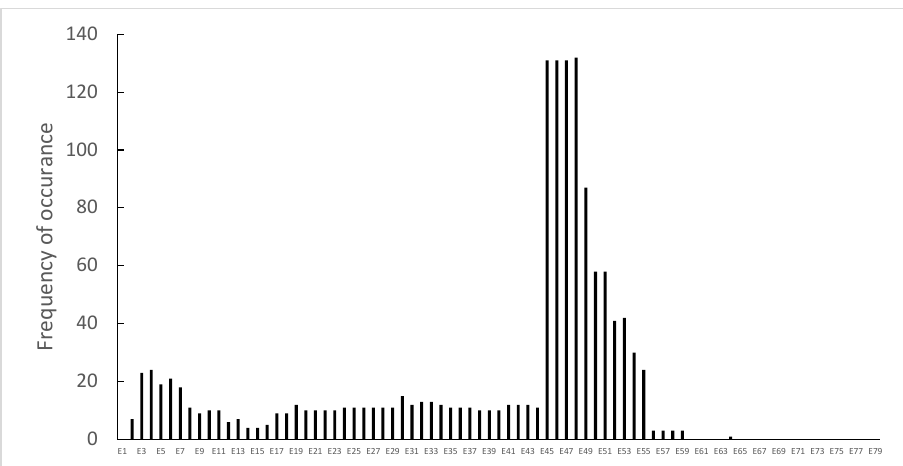
Figure 8. Frequency of single exon deletions in the dystrophin gene observed in patients with BMD. Eighteen BMD patients (6.7%) had large duplications, the largest of which involved 15 exons (E31–E44). Four patients (22.2%) had single exon duplications, which involved exons E2 (two patients) or E44 (two patients). The preferential hot spots of duplications were in exons E13–E20 at the 5 ′ end, and in exons E41–E44 at the 3 ′ end of the gene (Figure 9).